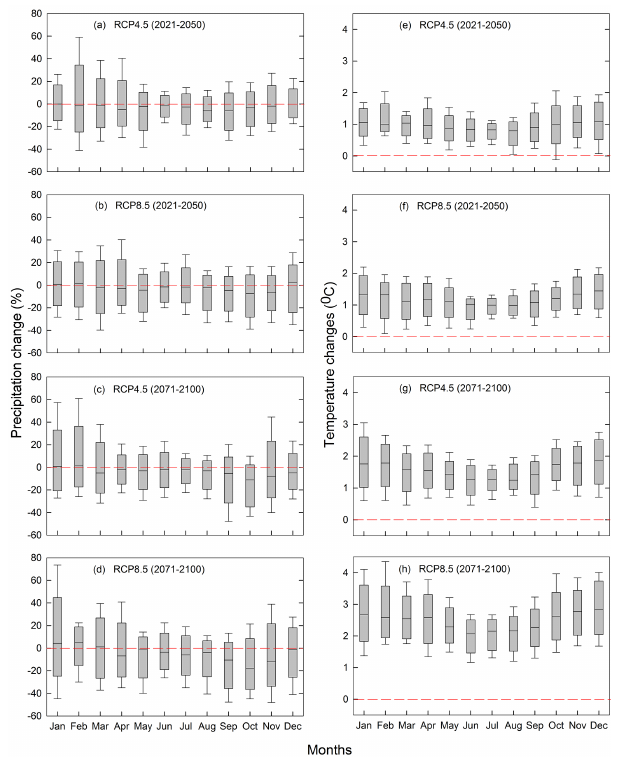
Figure 4. Box plots of percentage changes in the mean monthly precipitation (a, b, c, d) and changes in mean monthly temperatures (e, f, g, h) in the Goulburn–Broken catchment for the future periods 2021–2050 and 2071–2100 for the 38 CMIP5 runs of climate pro- jections. Changes are relative to the historical (1981–2010) mean monthly precipitation and temperatures. The lower boundary of the box indicates the 25th percentile, a line within the box marks the median, the upper boundary of the box indicates the 75th percentile and the whiskers are delimited by the maximum and